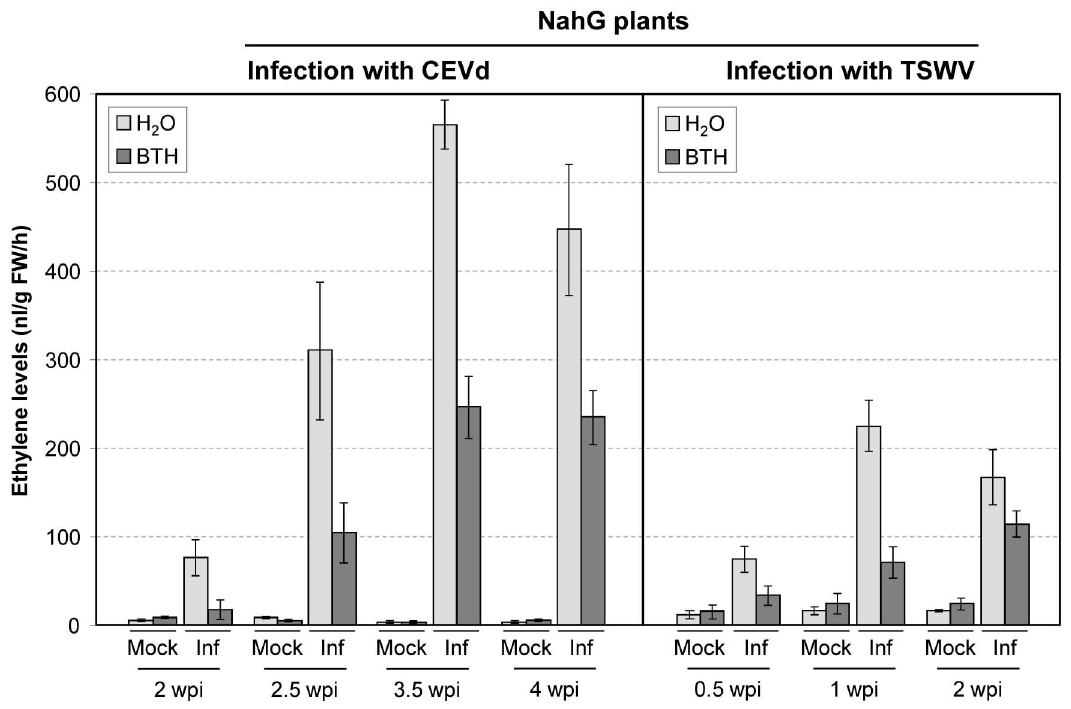
Fig 11. Time course of ethylene production in NahG tomato leaves infected with Citrus Exocortis Viroid (CEVd) or Tomato Spotted Wilt Virus (TSWV) and their corresponding controls. Samples were collectedat the indicatedtimes (weeks post-inoculation, wpi) for both mock-inoculated (Mock) and infected (Inf) plants, and ethylenewas measuredwith a gas chromatograph fitted with a flame ionizationdetector (FID). Data correspond to the mean ± SD of three biological replicates of one representative experiment. The experiments were repeated at least 3